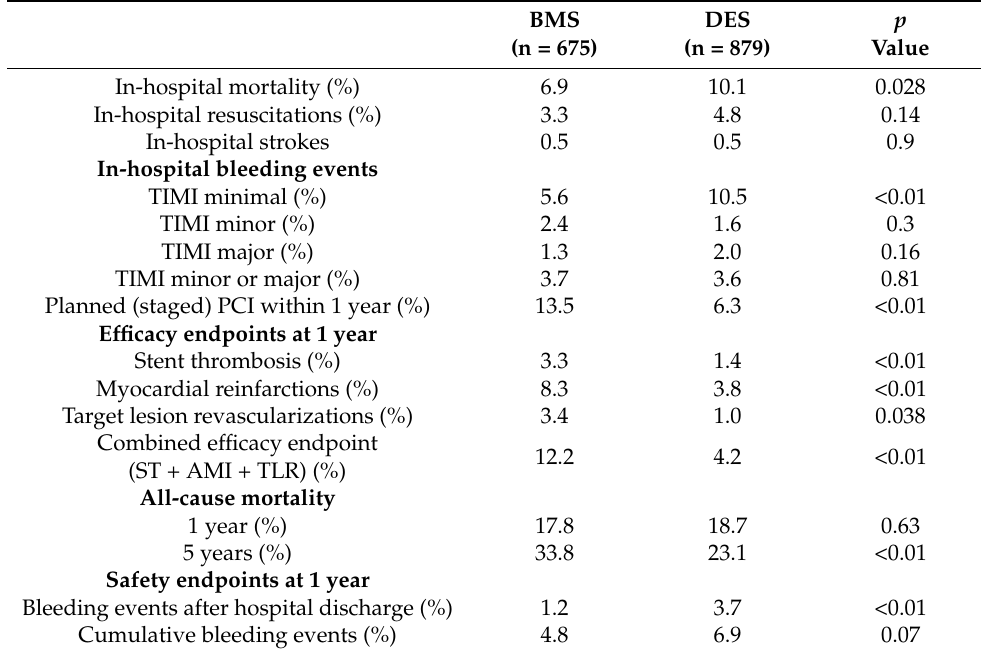
Table 3. Outcome of diabetic patients with STEMI treated with BMS vs.